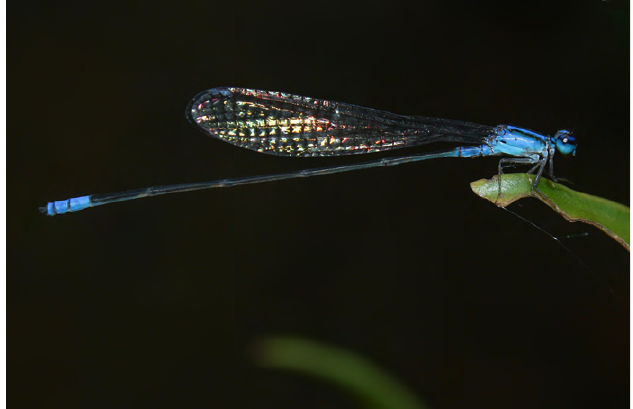
Figure 5. Archibasis lieftincki ♂